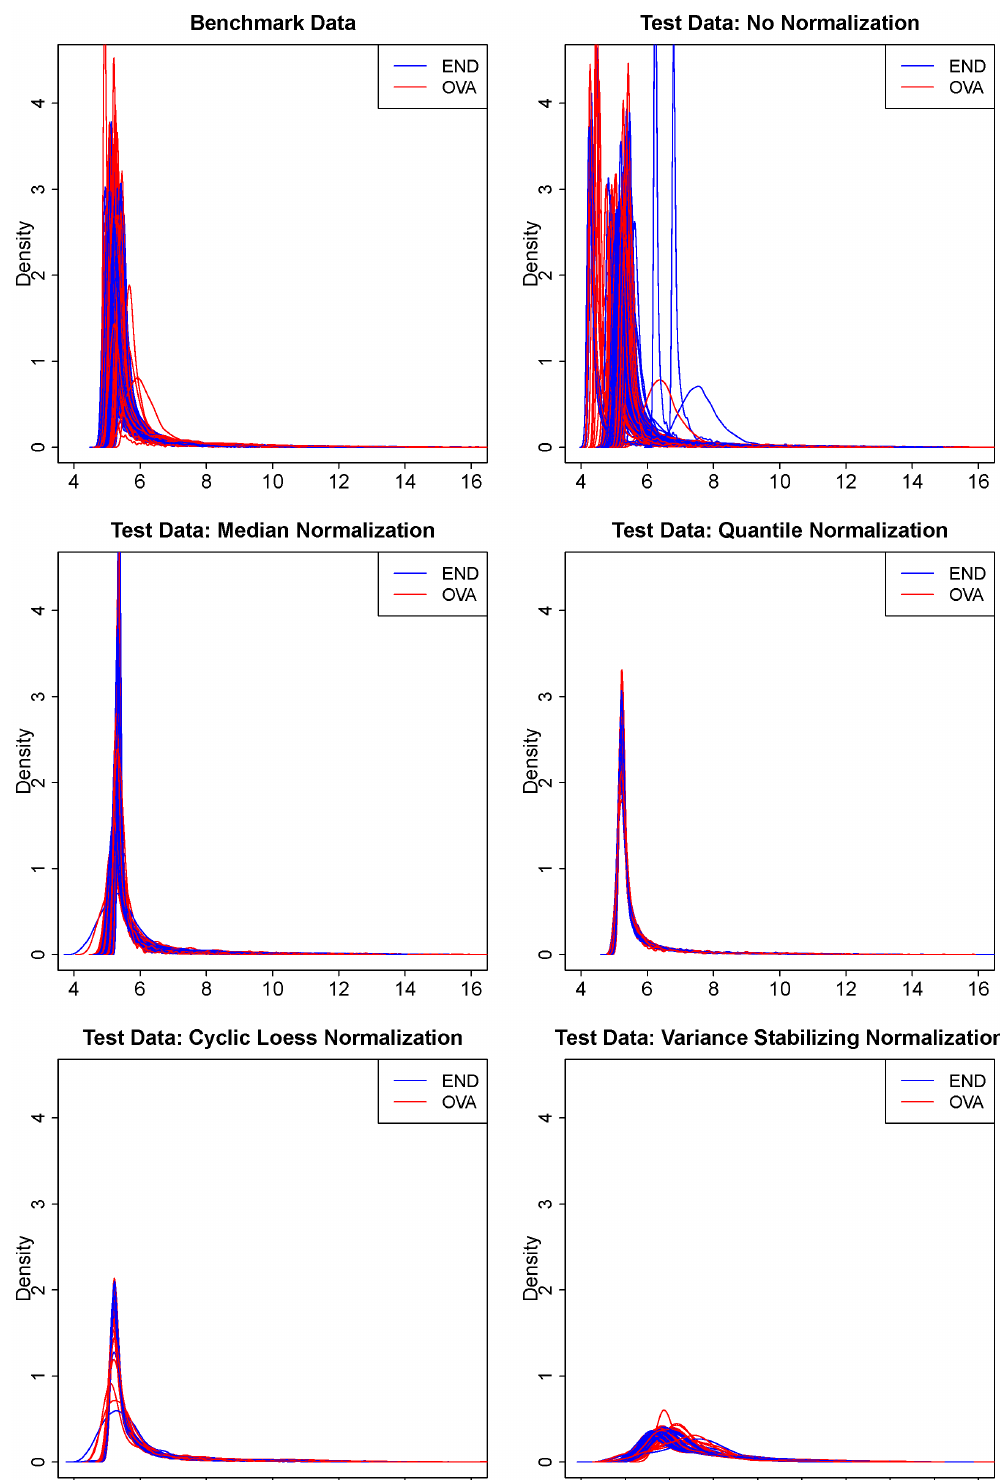
Figure 1. Density curves for the benchmark data and the test data with or without normalization. Each density curve represents the data for one array. Arrays for endometrial samples are colored in blue, and arrays for ovarian samples in red.